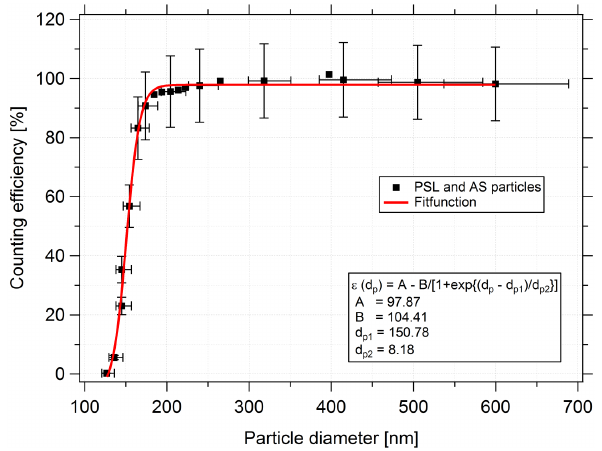
Figure 10. Counting efficiency of the CARIBIC OPSS for UT par- ticles (refractive index of 1.47-i0.006).